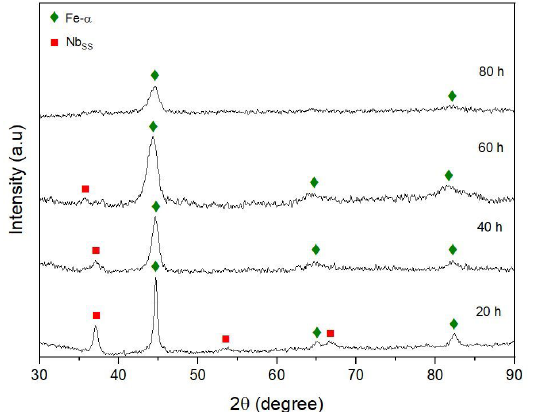
Figure 10. Fe-15at.%Nb sample diffractogram after milling with methanol PCA.